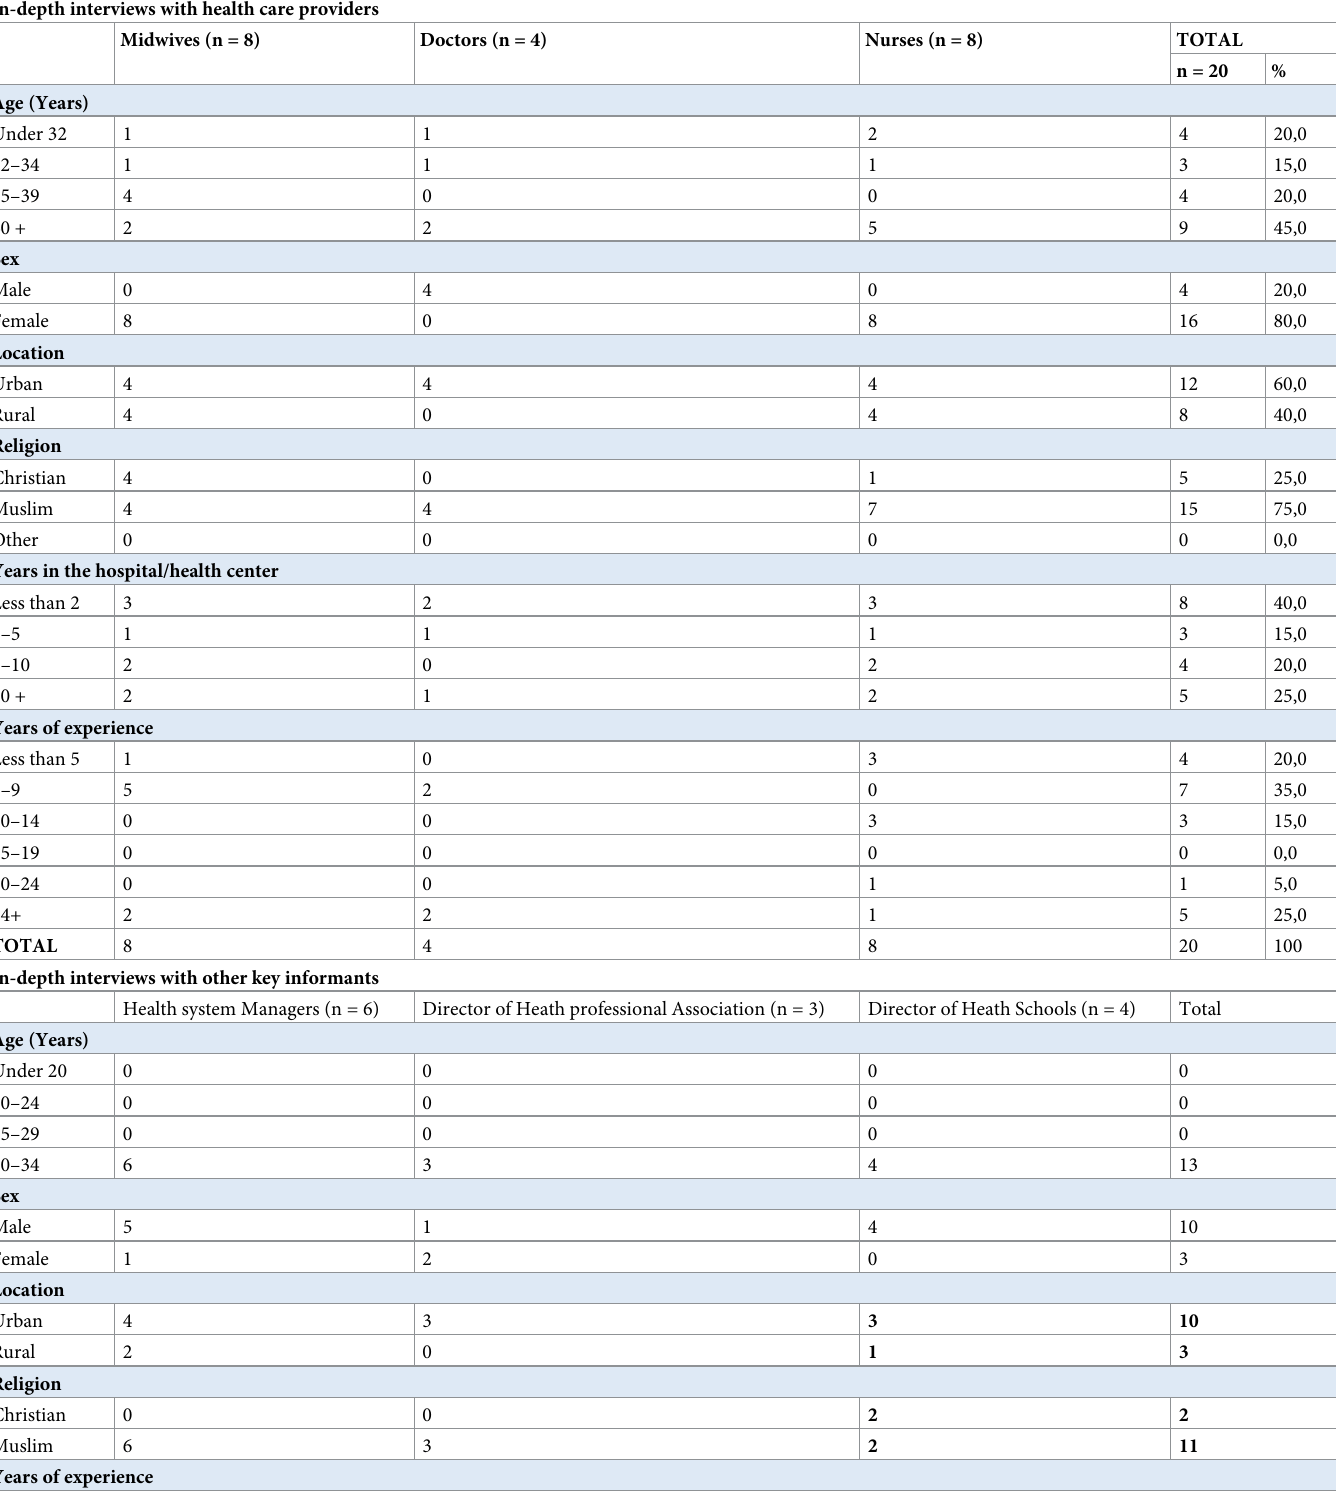
Table 3. Socio-demographics characteristics of health care providers and other key informants in qualitative interviews (n =